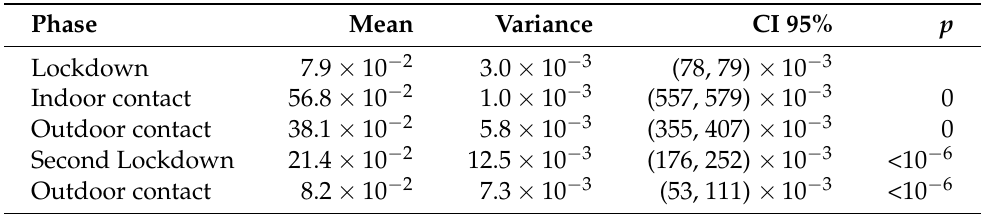
Table 9. Histogram for the mean values of β E at the different stages of lockdown in Germany.